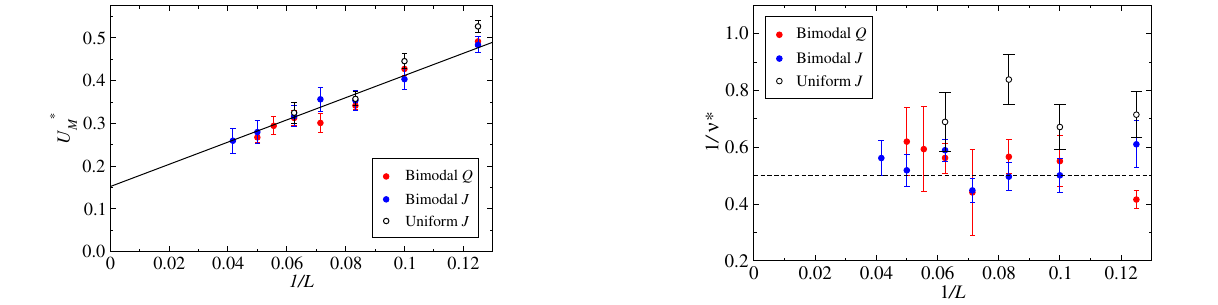
FIG. 17. Inverse system size dependence of the correlation length exponent defined according to Eq. (13). The disorder distributions are the same as those in Fig. 16. The conjectured exponent ν ¼ 2 is indicated by the dashed line.